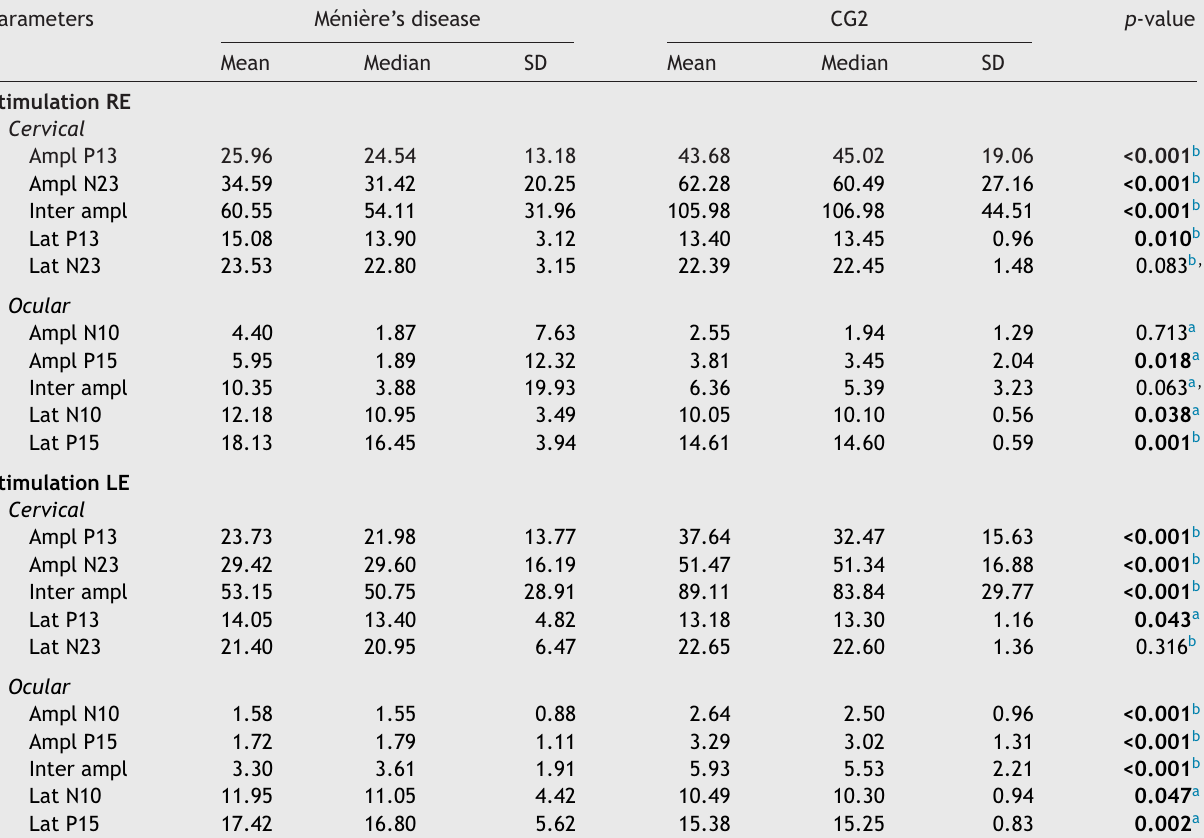
Comparison of individuals with Ménière’s disease and the control group for latency (ms) and amplitude ( (cid:2) V) for combined cervical and ocular VEMP.